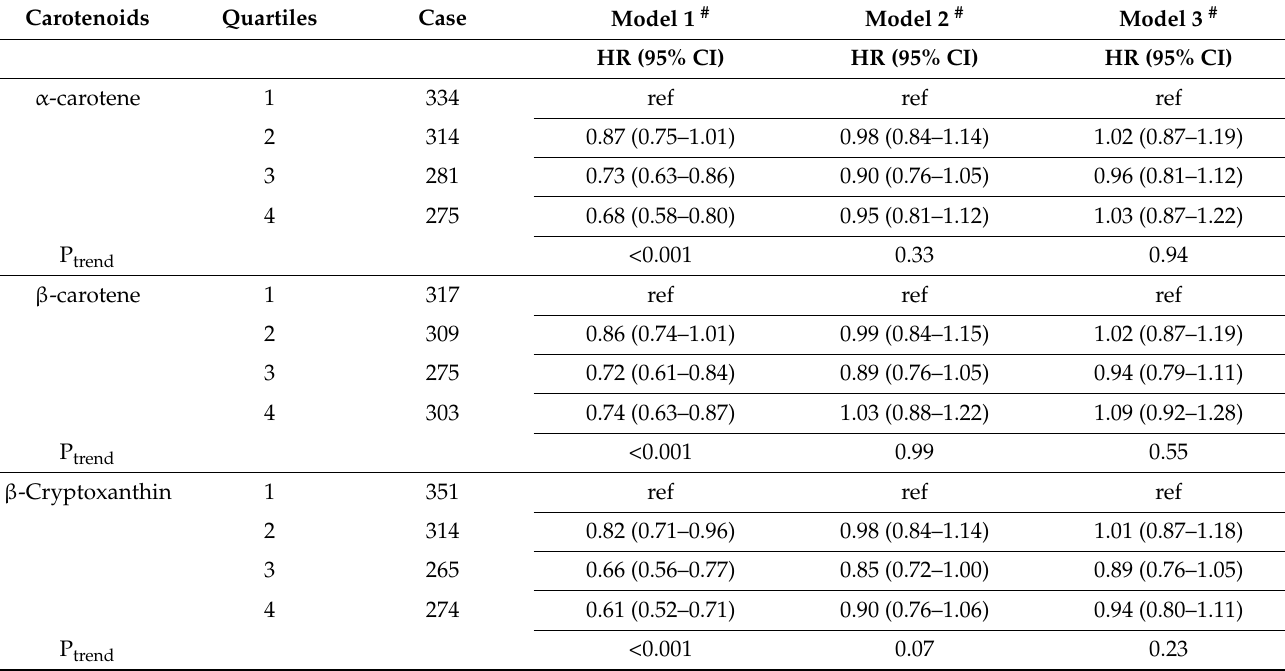
Table 2. Associations of dietary intakes of carotenoids and vitamin A with lung cancer risk,